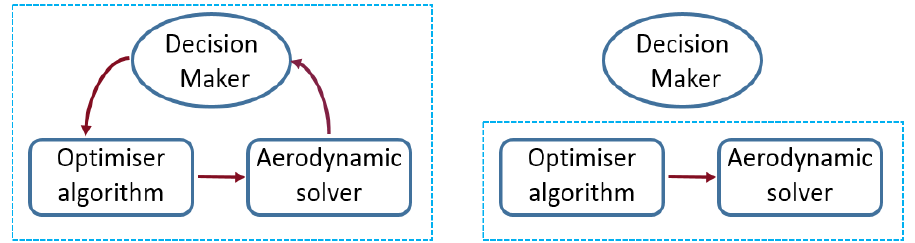
Figure 1. Left panel: a preference based design loop (interactive). Right panel: the conventional design loop (non-interactive).